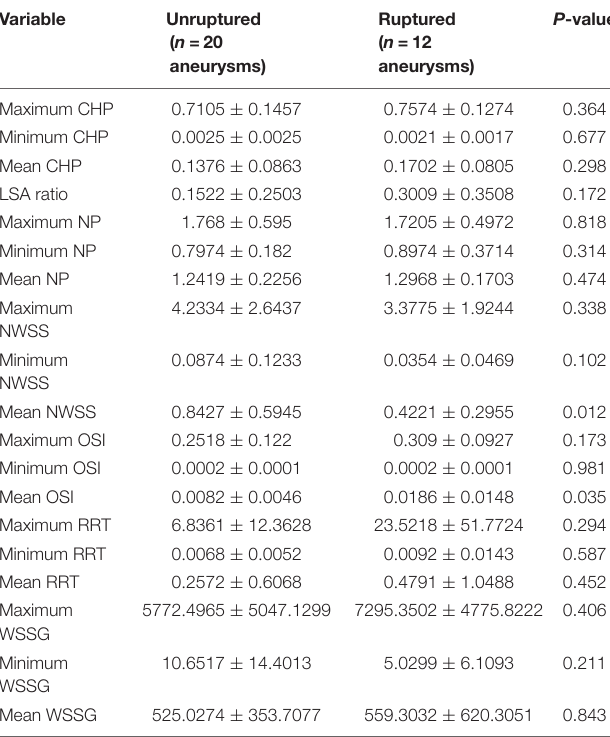
TABLE 2 | Hemodynamic parameters of the ruptured and unruptured PAA